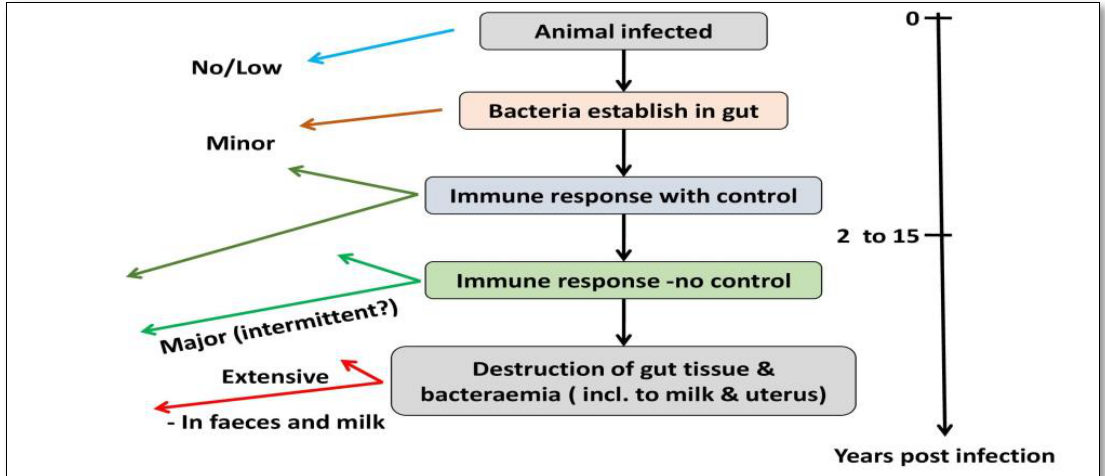
Figure 3. Pathogenesis of MAP infection in cattle.